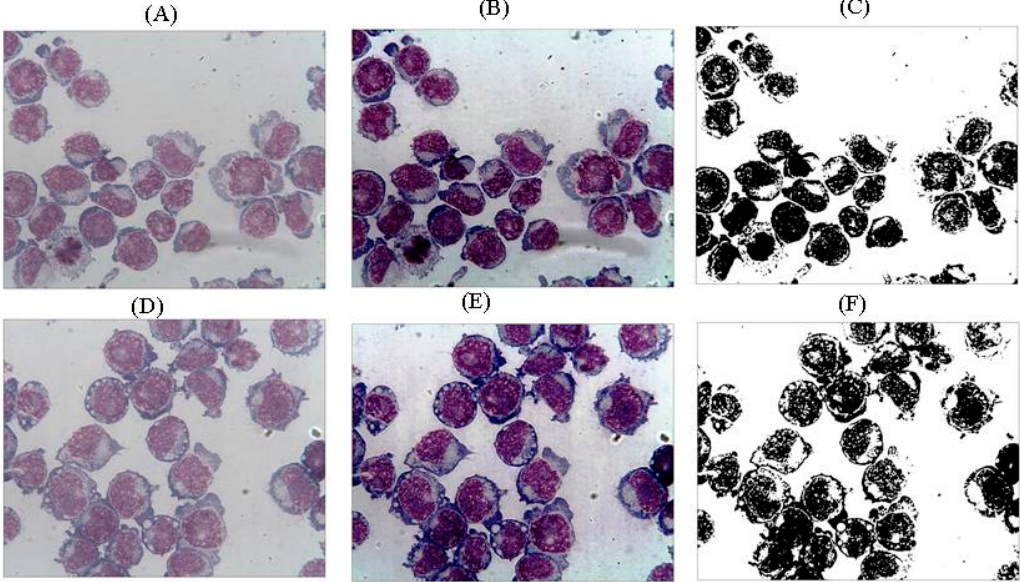
Figure 2. ( A ) Jurkat cells: Normoxia image original version, ( B ) Jurkat cells: Normoxia image after